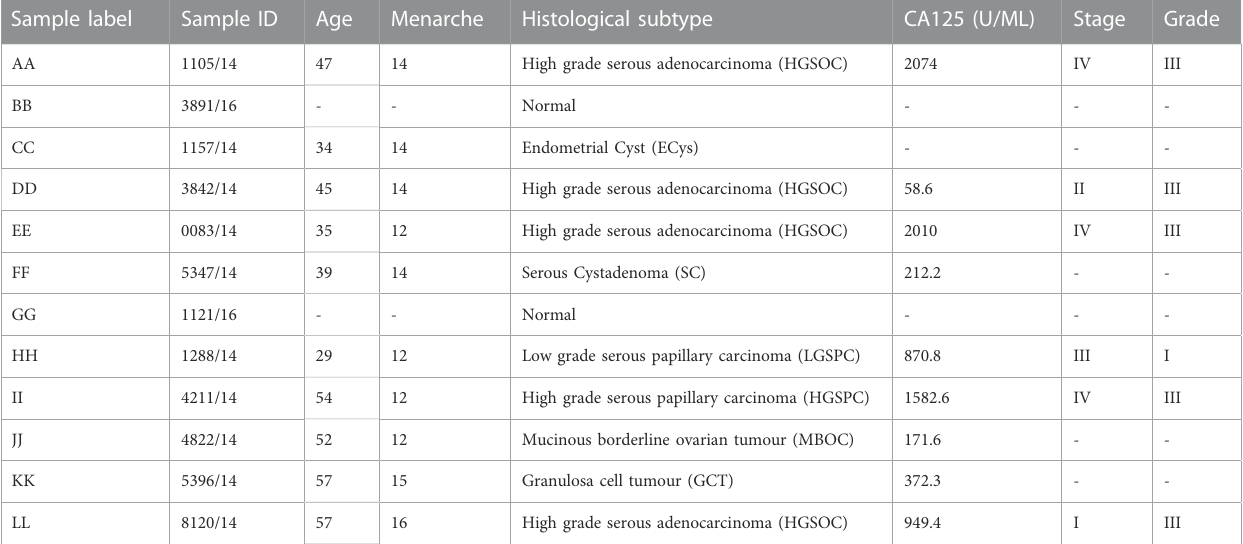
TABLE 1 Patient information. Sample